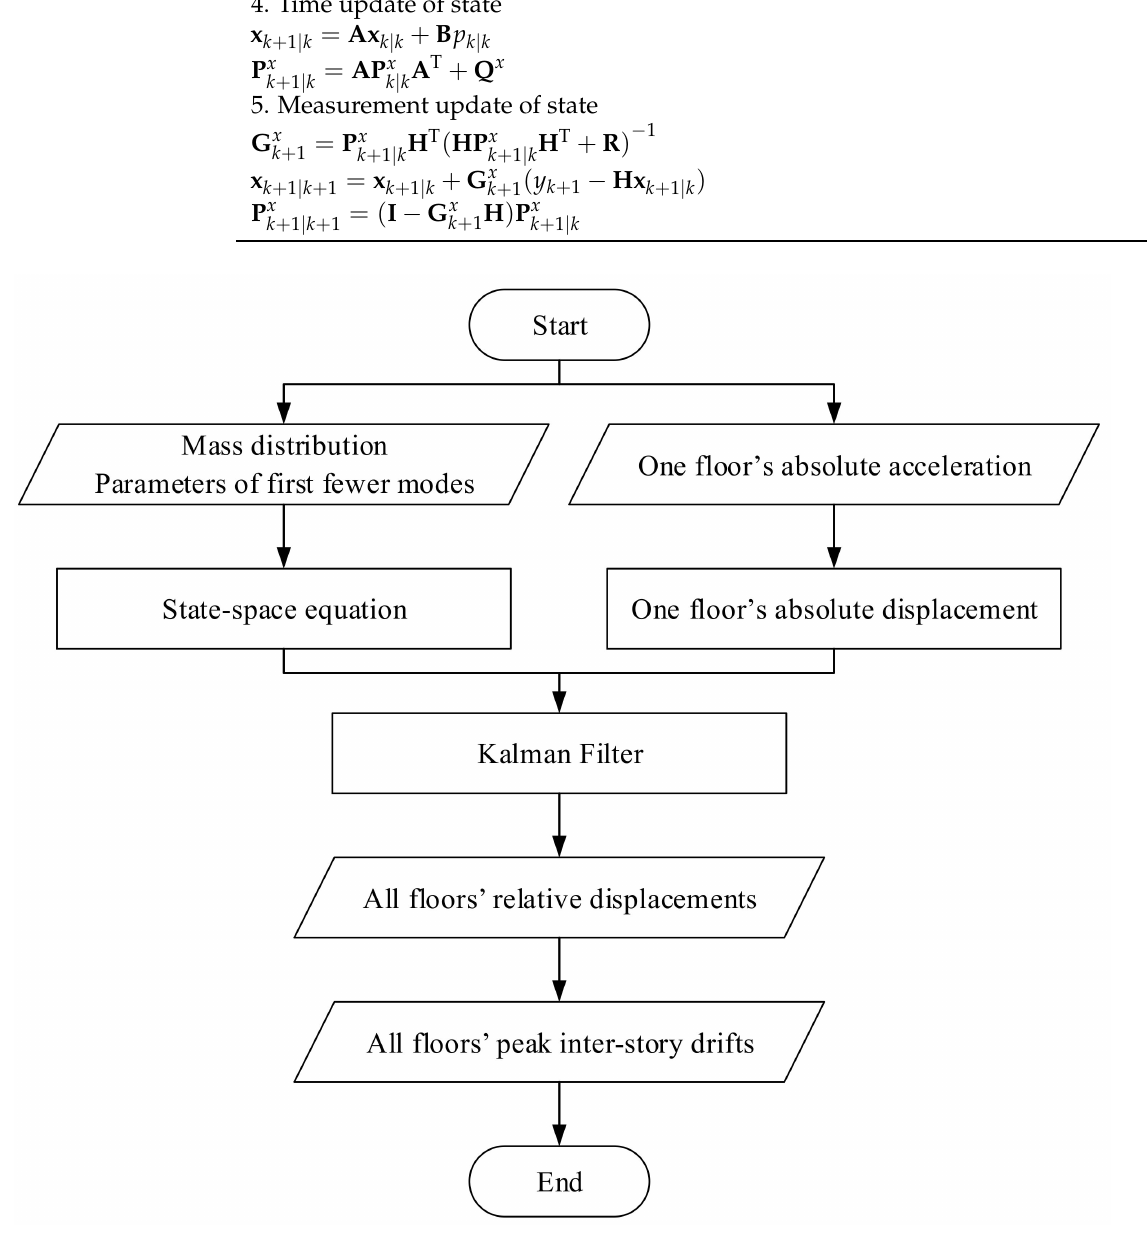
Figure 2. Procedure of the proposed